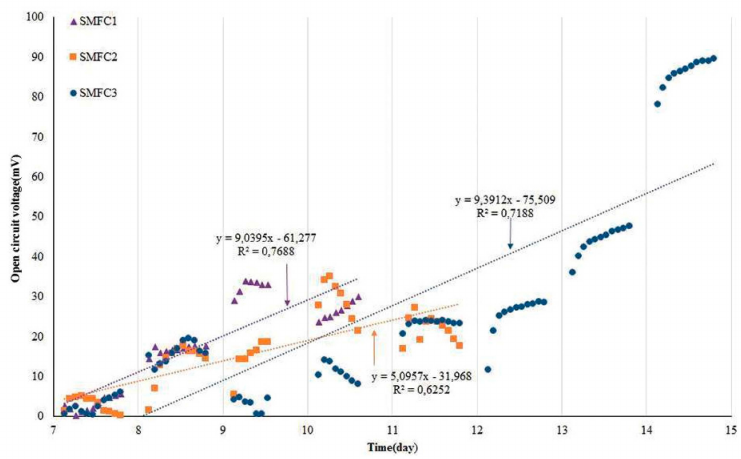
Figure 2. Linear increasing stage of the SMFCs before reaching the steady